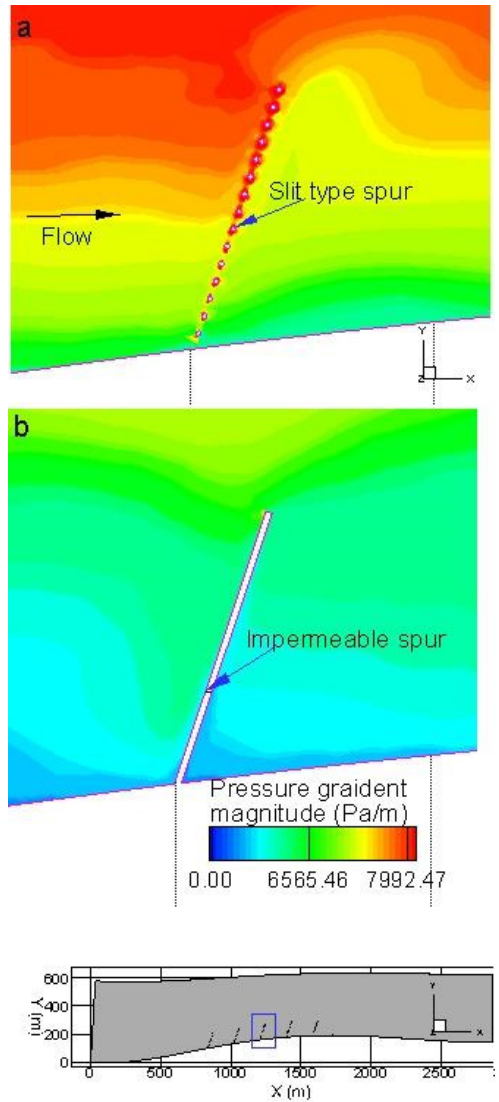
Figure 20. Distribution of pressure gradient magnitude around the third spur (near bed): ( a ) slit type spur, ( b ) impermeable spur.